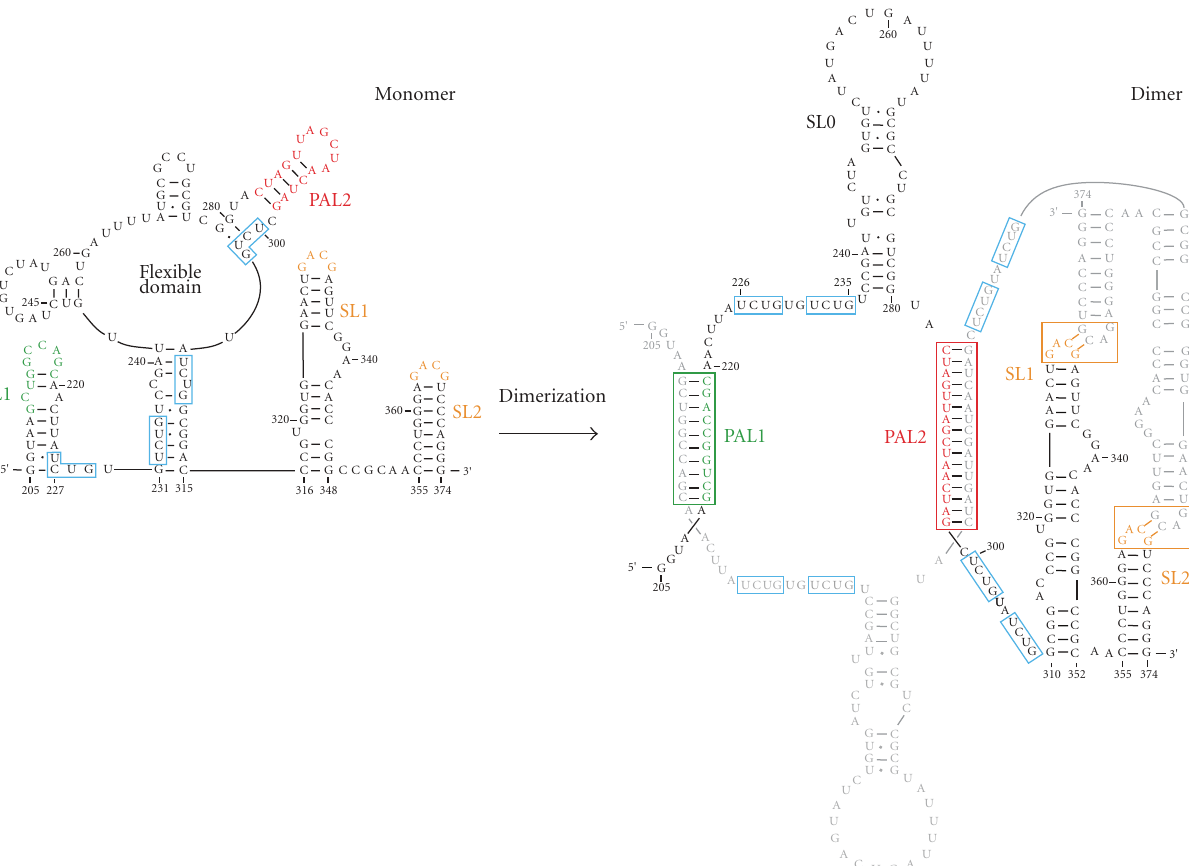
Figure 4: The Moloney MLV dimerization/packaging signal. The figure shows the secondary structure of the 170-base “minimal dimerization active sequence” (nt 205–374) [19] in both monomeric and dimeric forms. Two palindromic sequences, “PAL1” (green) and “PAL2” (red), are contained within stem loops in the monomer but open out and pair intermolecularly in the dimer. The two monomers are also connected in the dimer by base pairing between the “CG” moieties in the “GACG” loops of a pair of stem loops (“SL1” and “SL2”, orange). The RNA also contains two motifs with the sequence UCUG-UPu-UCUG (blue boxes); these are partially or fully base-paired in the monomer but become unpaired as a result of the RNA rearrangements accompanying the intermolecular base pairing of PAL1 and PAL2. These bases are a crucial element in ψ , as replacement of the four UCUG sequences with UCUA prevents selective packaging of the viral RNA; the exposure of these bases in dimers, but not monomers, presumably explains the selective packaging of dimeric RNA [20]. (Figure reproduced from Trends in Biochemical Sciences, Copyright 2011, with permission from Elsevier [21].)